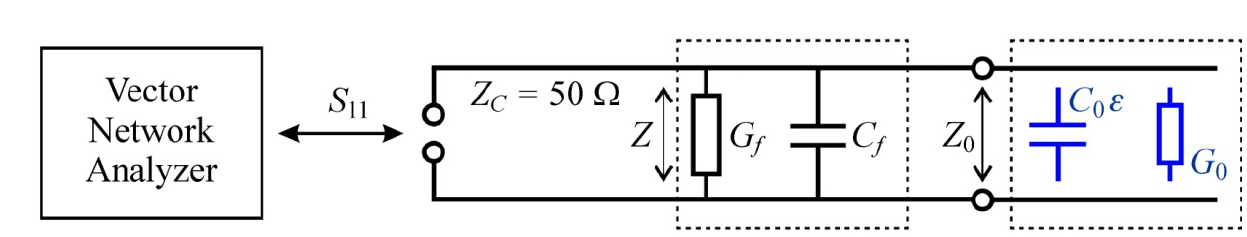
Figure 5. Localization of the sensor impedances in the model Z